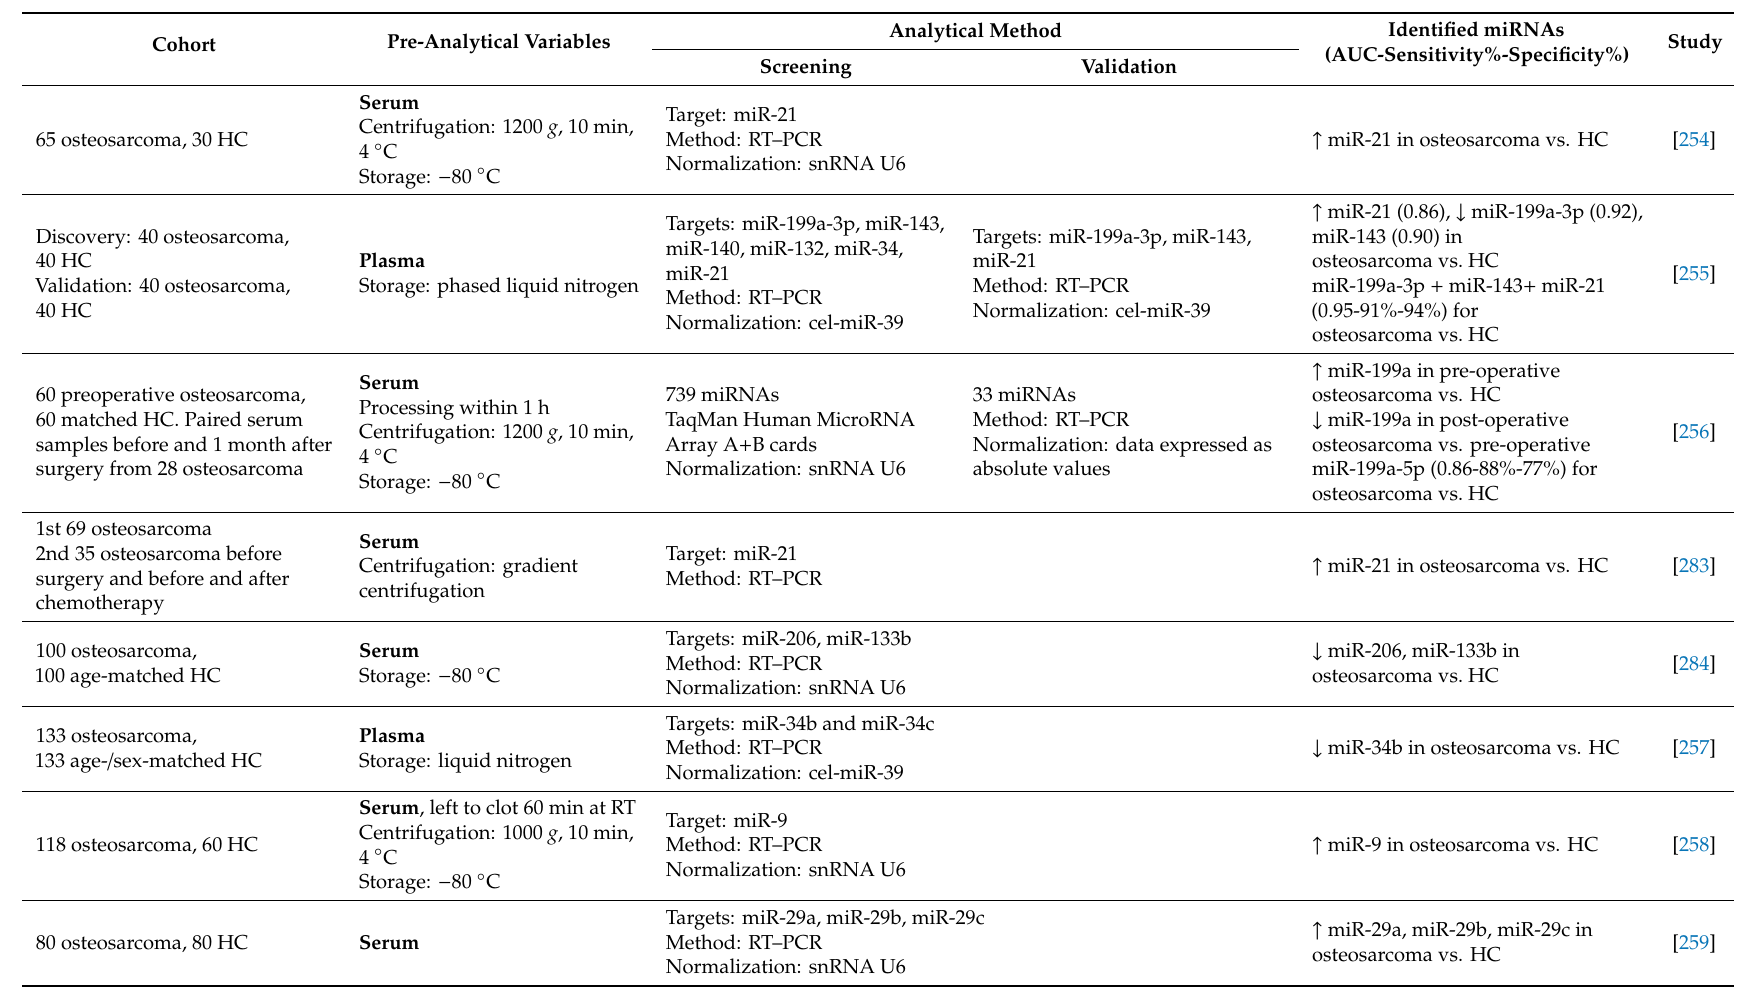
Table 4. Circulating miRNAs associated with